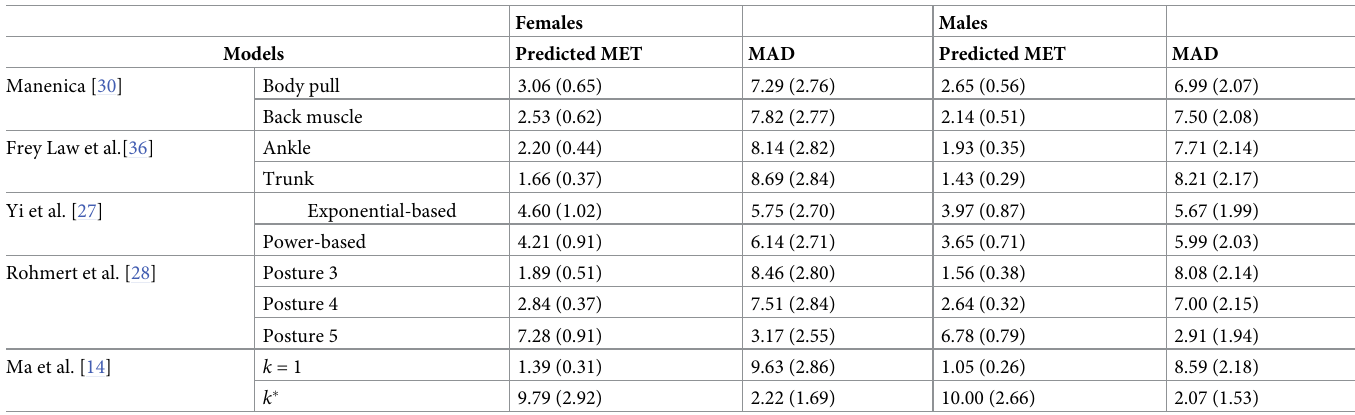
Table 5. MAD (min) using the MET models in the literature.